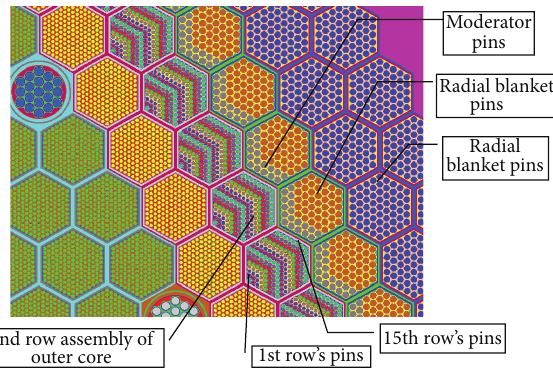
Figure 4: Pin wise power peaking factor in the 2 row assembly of the outer core.